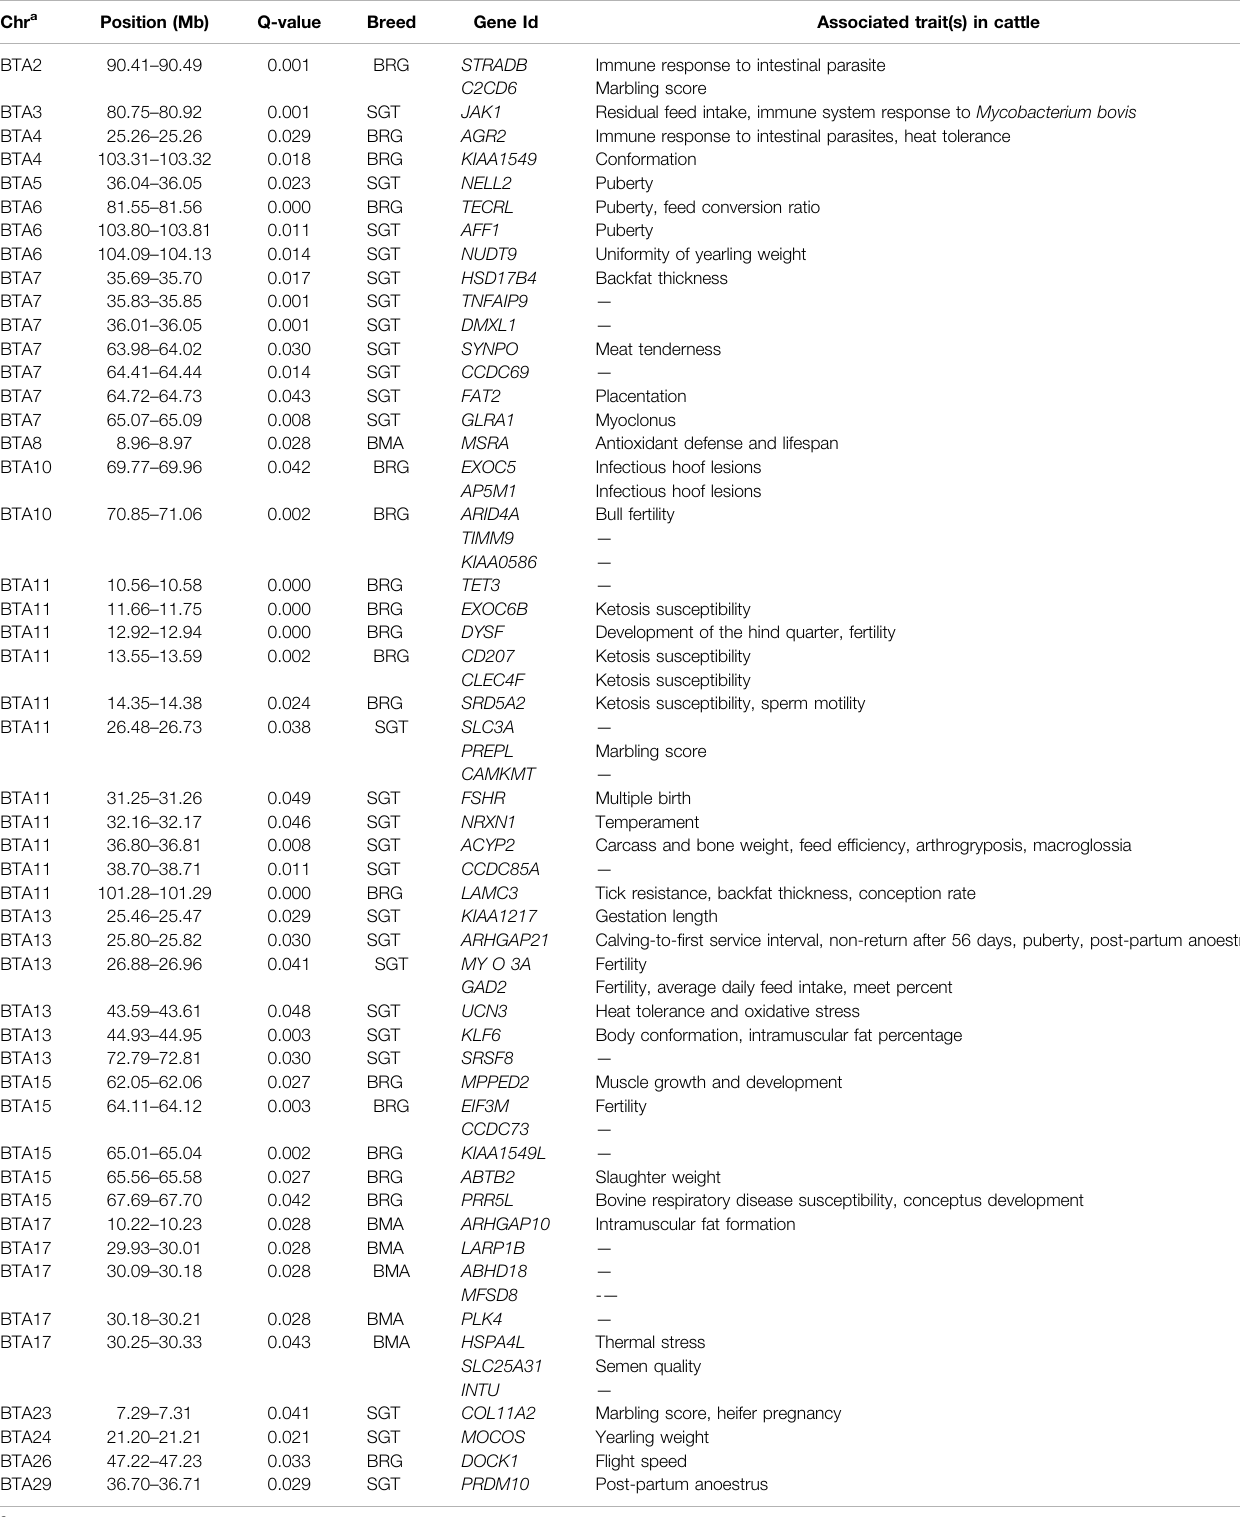
TABLE 2 | Genomic regions detected by the DCMS analyses as being under putative selection in Beefmaster (BMA), Brangus (BRG), and Santa Gertrudis (SGT) breeds. Chr